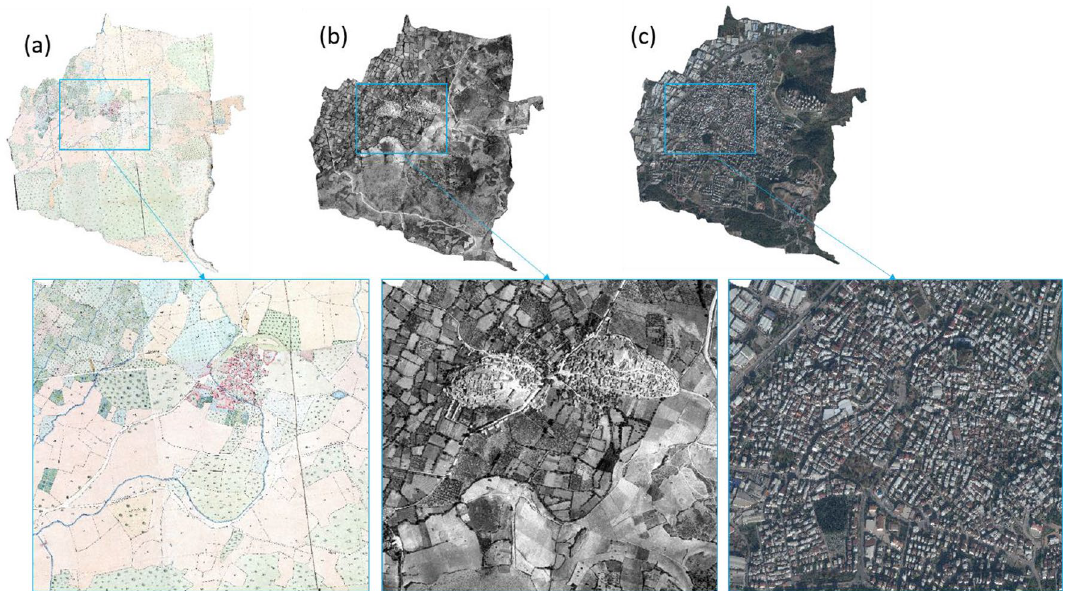
Figure 4. Geospatial dataset for the Kestel study region. ( a ) 1858 Cadastral map, ( b ) 1955 aerial photo, and ( c ) 2020 WV-3 satellite image (finer details shown in the inset images highlighted by Blue boxes).